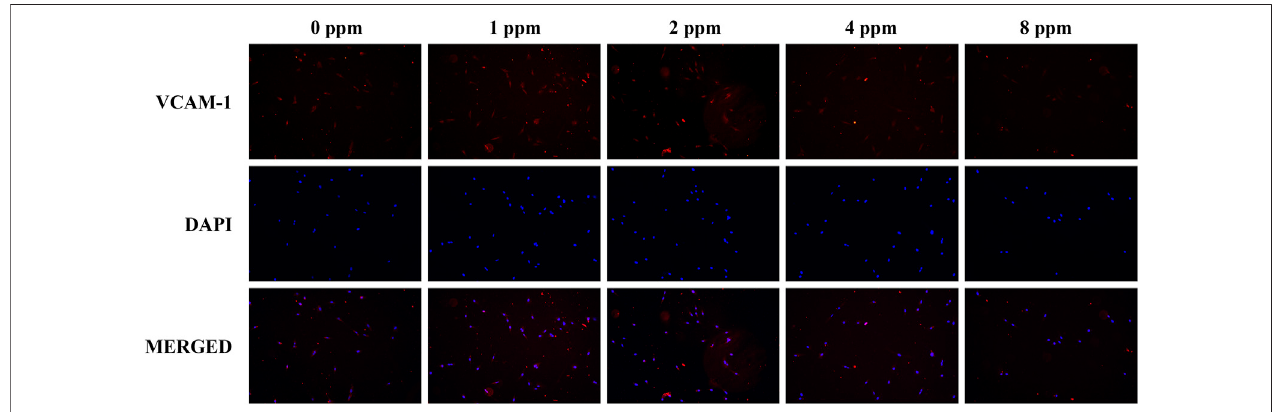
FIGURE 9 | Immunolocalization of VCAM-1 (red) and nuclei (blue). The merged images show that the treatment of 1 and 2 ppm zinc ions promoted VCAM-1 expression signi fi cantly. All images are displayed at ×200 magni fi cation.